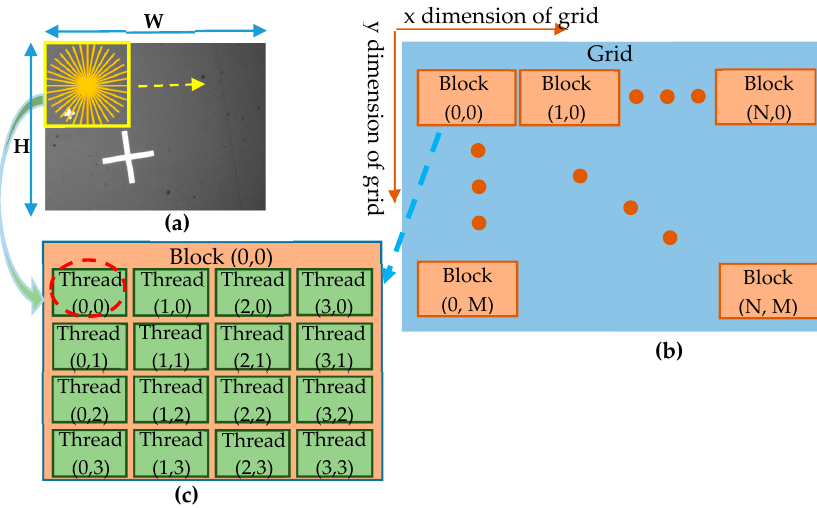
Figure 5. Structure of a 2D grid used to carry out the steps of the RST algorithm. ( a ) Scanning line of the radial features on the test image with a size of W × H; ( b ) structure of the grid with a size of N × M blocks; and ( c ) structure of the block with a size of 4 × 4 threads.